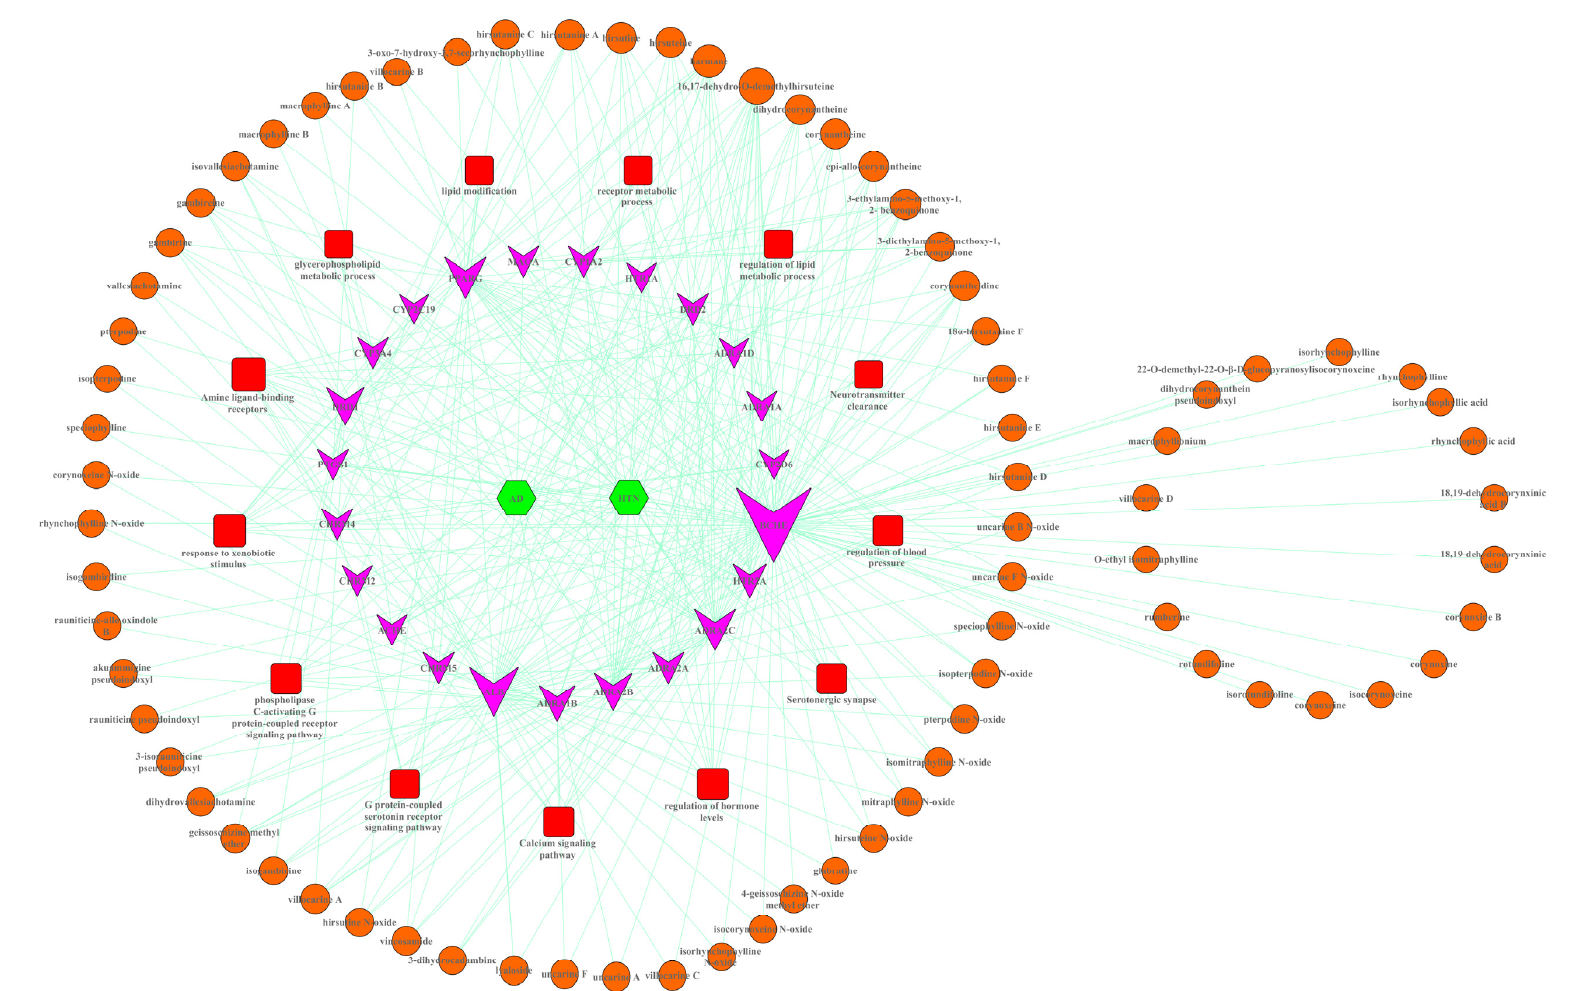
Figure 8. Comprehensive representation of the built network of Uncaria alkaloids, AD, and hypertension. Diseases are represented by hexagons (green), target genes by arrowheads (magenta), Uncaria alkaloids by circles (orange), and pathways by squares (red).